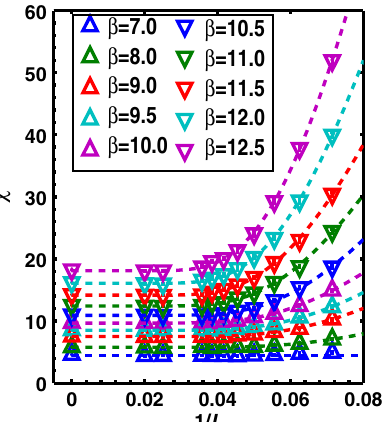
FIG. 13. The finite-size scaling of χ ð T; L Þ at n ¼ 1 , V ¼ 0 , and J ¼ 2 in the low-temperature critical region with the scaling ansatz χ ð T; L Þ ¼ aLe − L=b þ χ ð T Þ used. Values of β ¼ 1 =T are presented in the legend.